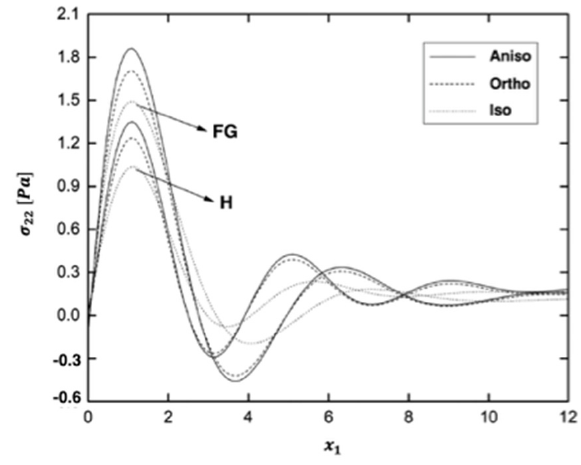
Figure 10. Variation of the thermal stress wave σ 22 along x 1 − axis in the functionally graded (FG) and homogeneous (H) fiber-reinforced plates for different materials.